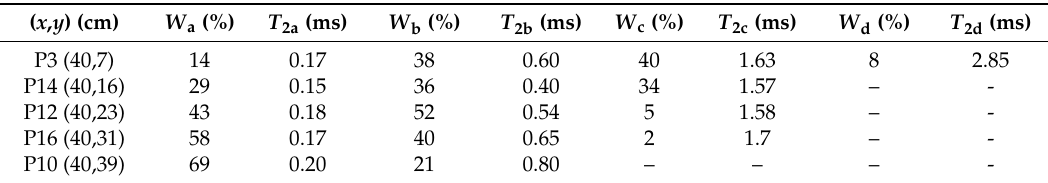
Table 2. T 2 relaxation times and relative populations obtained at different heights in region A of the tuff wall. The error on the parameters is less than 10% of the nominal